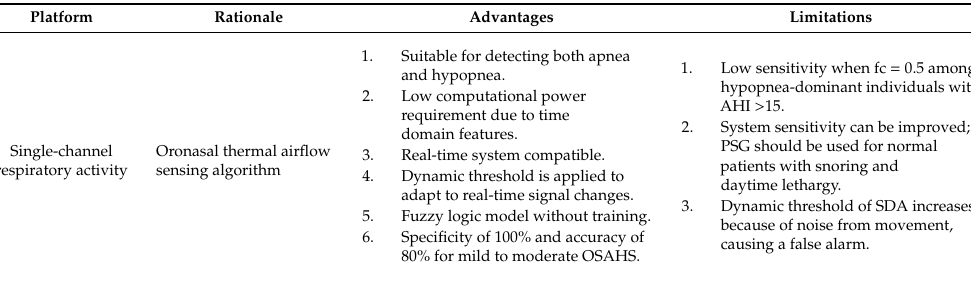
Table 6. Characteristics of the proposed detection